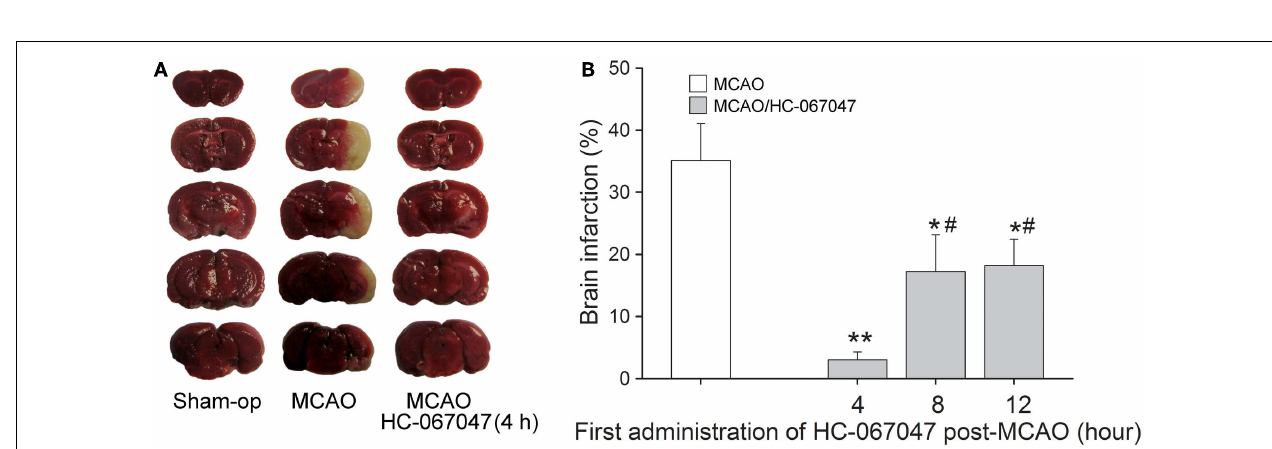
Time-window of neuroprotective effect of HC-067047. Bar graphs show the mean infarct volume percentage in MCAO mice that were treated with HC-067047 starting 4, 8, and 12h post-MCAO. ** P < 0.01 and * P < 0.05 vs. vehicle-treated MCAO mice, # P < 0.05 vs.